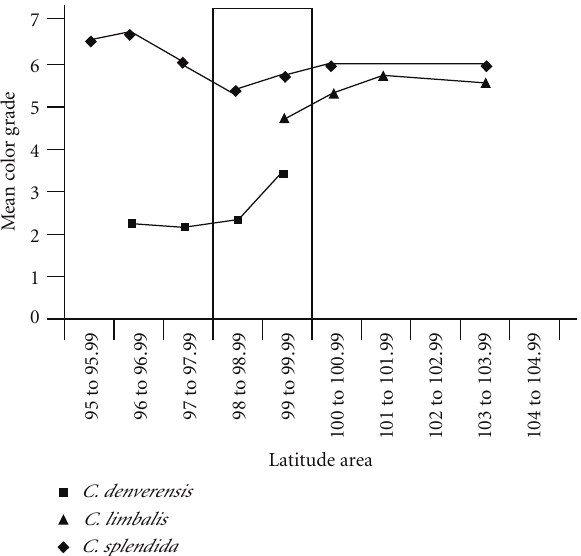
Figure 10: Graph of mean pronotal color by code for C. denverensis , C. limbalis , and C. splendida by longitude. Region of character con- vergence for C. denverensis and C. splendida depicted by rectangle.